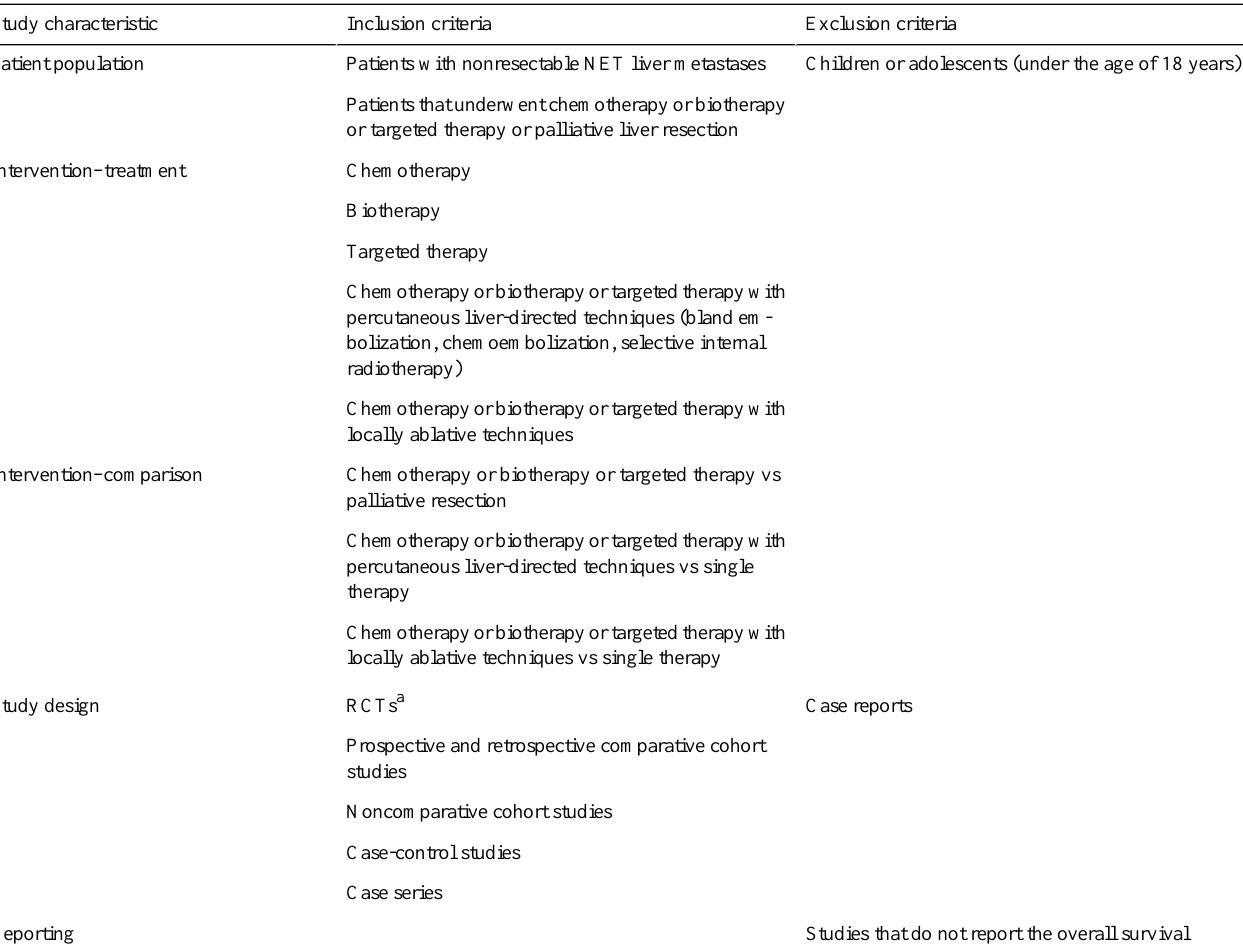
Table 4. Eligibility criteria for review 4: when should chemotherapy, targeted therapy or biotherapy be used in patients with nonresectable neuroendocrine liver